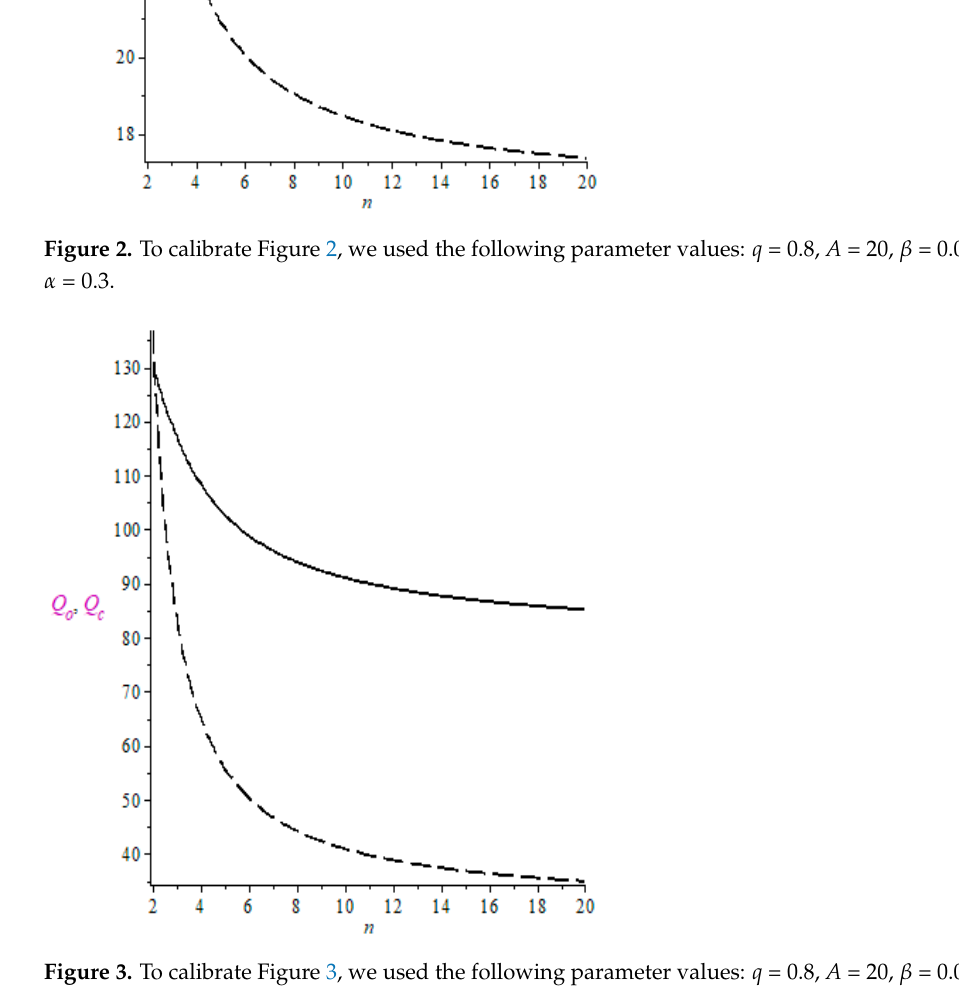
Figure 3. To calibrate Figure 3, we used the following parameter values: q = 0.8, A = 20, β = 0.09, and α = 0.55 .